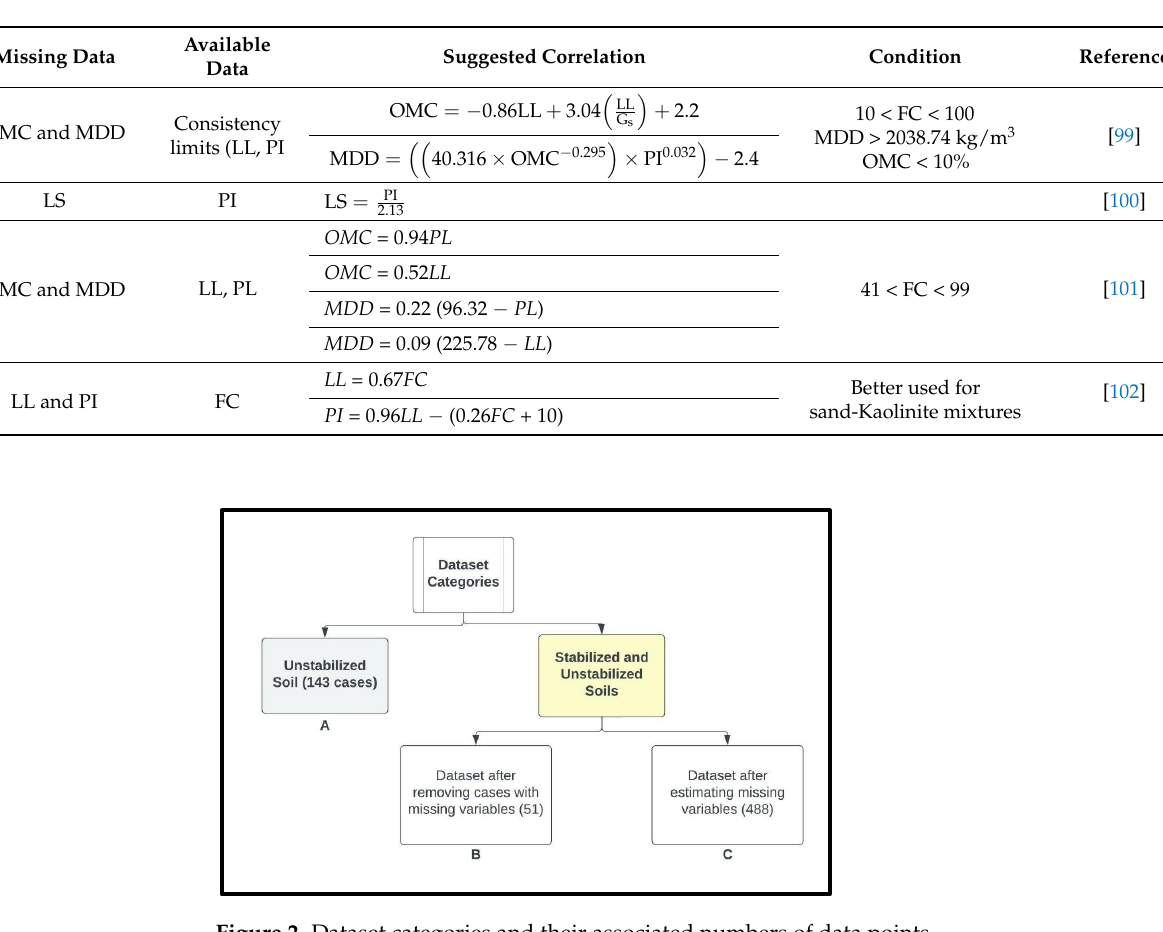
Table 5. Some correlations used for soil characteristics estimation.